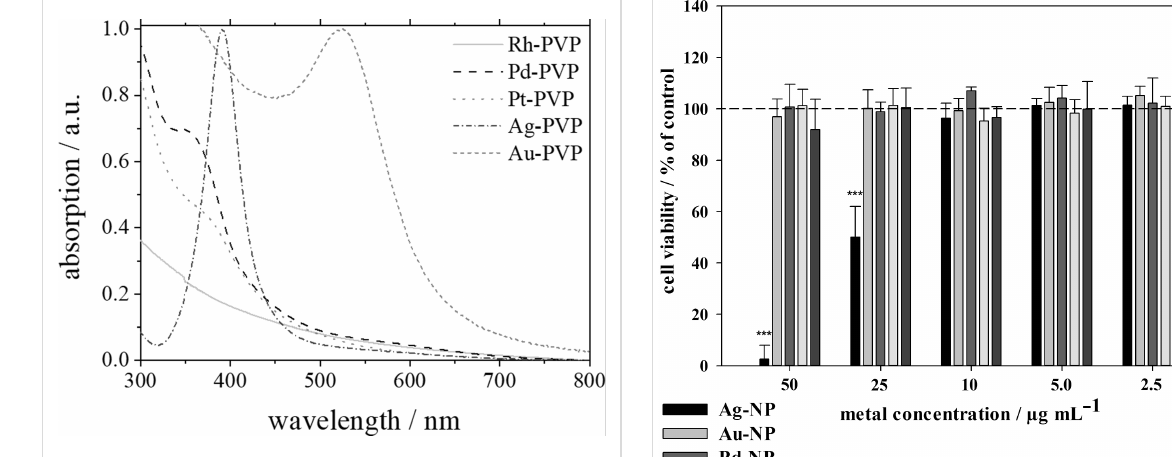
50 ppm, indicating that no oxidative release of ions occurs.